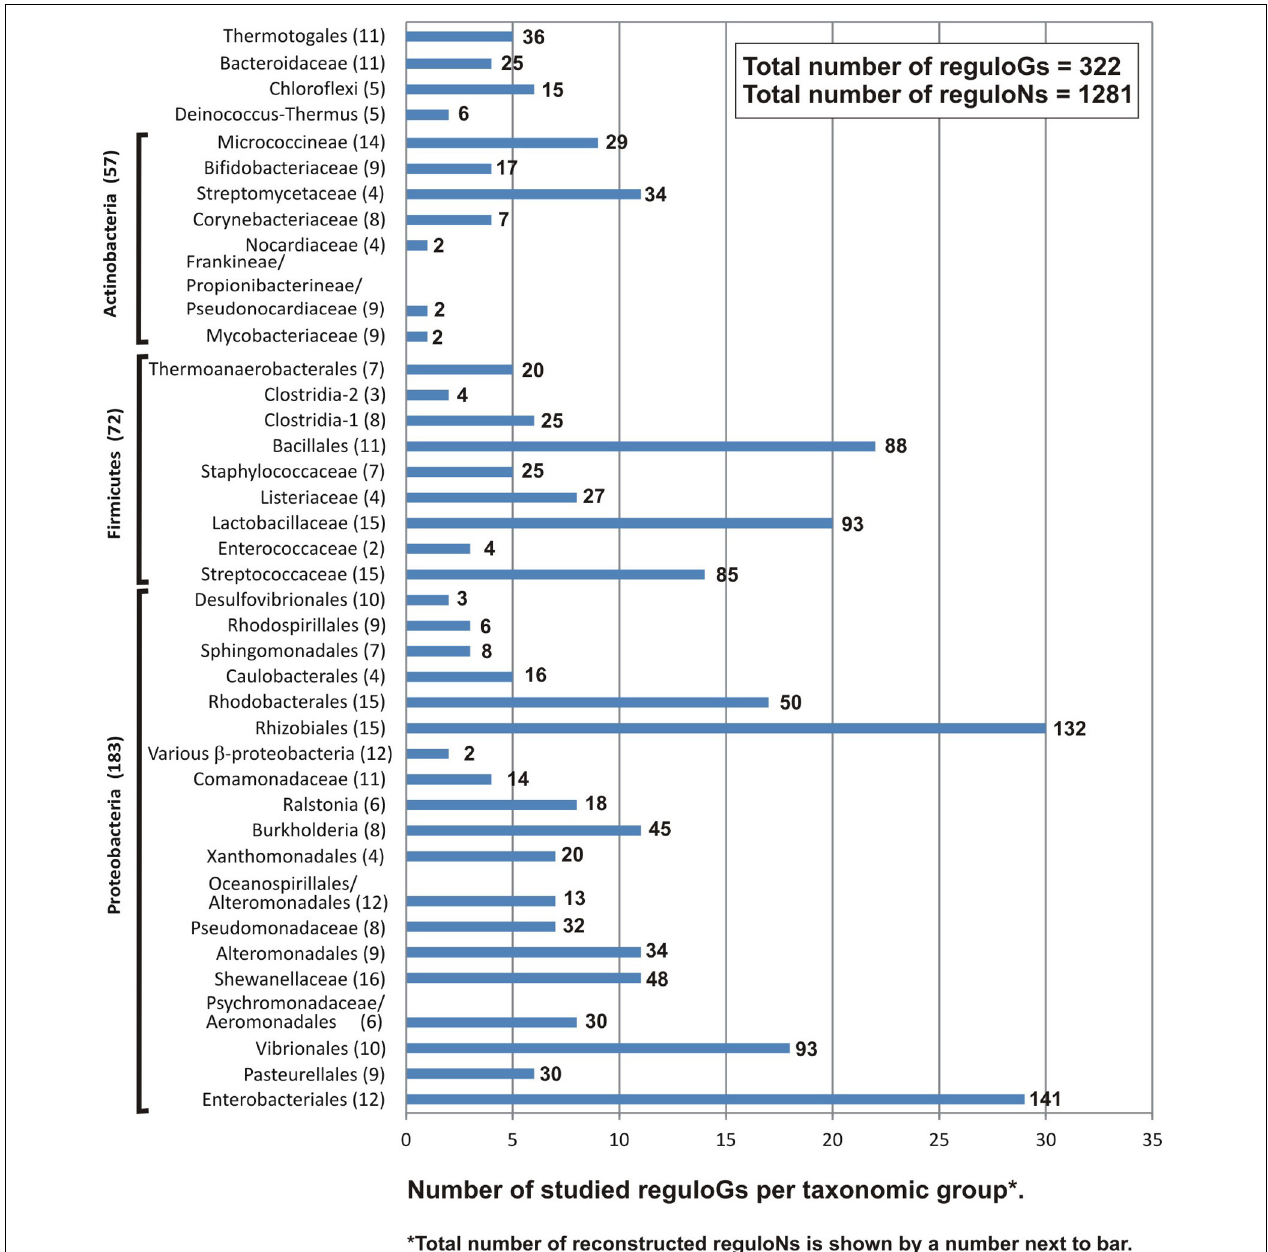
FIGURE 1 | Distribution of LacI-TF regulons and regulogs in the analyzed taxonomic groups of